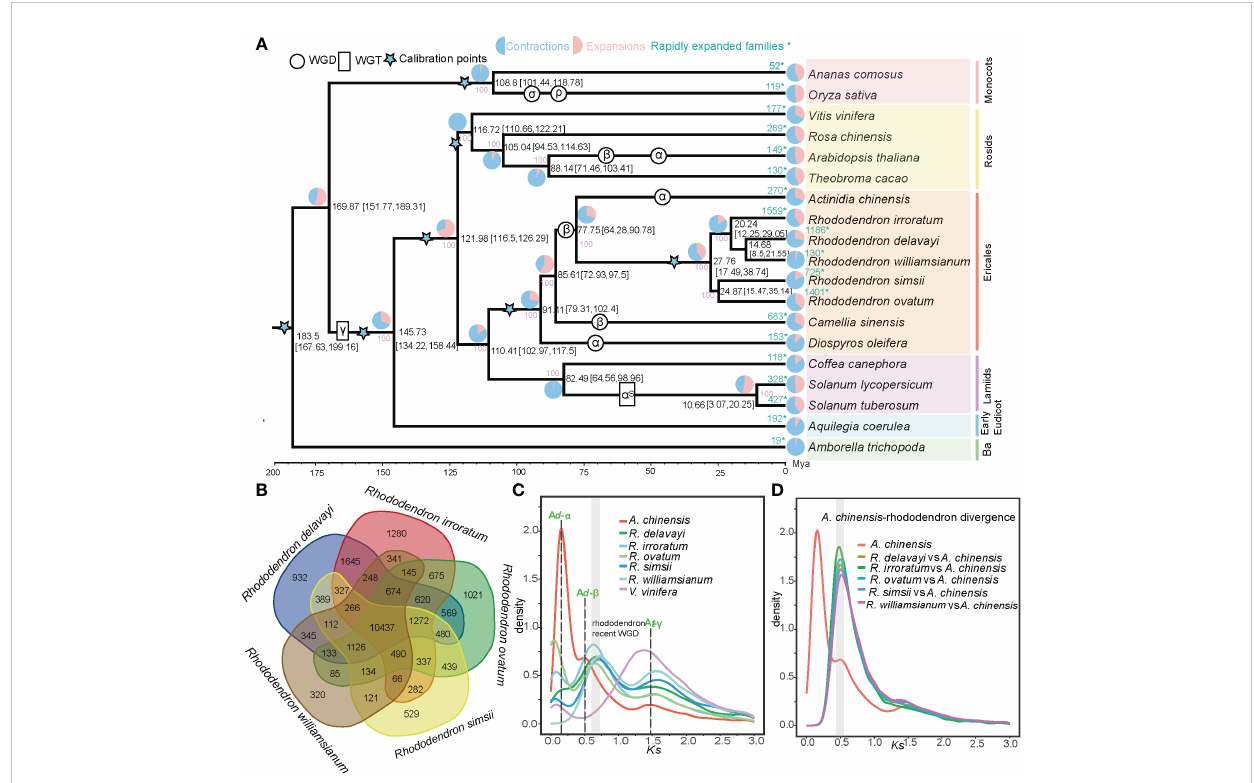
FIGURE 2 Evolutionary and comparative genomic analyses of Rhododendron species and representative angiosperms. (A) The phylogenetic tree of 19 angiosperms. All branches had 100% bootstrap support. Divergence time is displayed with 95% HPD in parentheses. Blue stars represented the calibration points. Estimated WGD/WGT events were placed according to results from our study and from those of previous investigations. The pink, light blue and light green numbers along particular branches indicated the number of orthogroups that undergone expansion, contraction and rapid evolution, respectively, * indicated the rapidly expanded families. (B) Shared and unique orthogroups among fi ve Rhododendron species. (C) Synonymous substitution rate ( Ks ) distributions of syntenic paralogous genes for fi ve.Rhododendron species, V. vinifera and A chinensis Ad- a ; Ad- b and At- g are illustrated with dotted lines. (D) Ks distributions of syntenic orthologous genes between A chinensis and fi ve Rhododendron